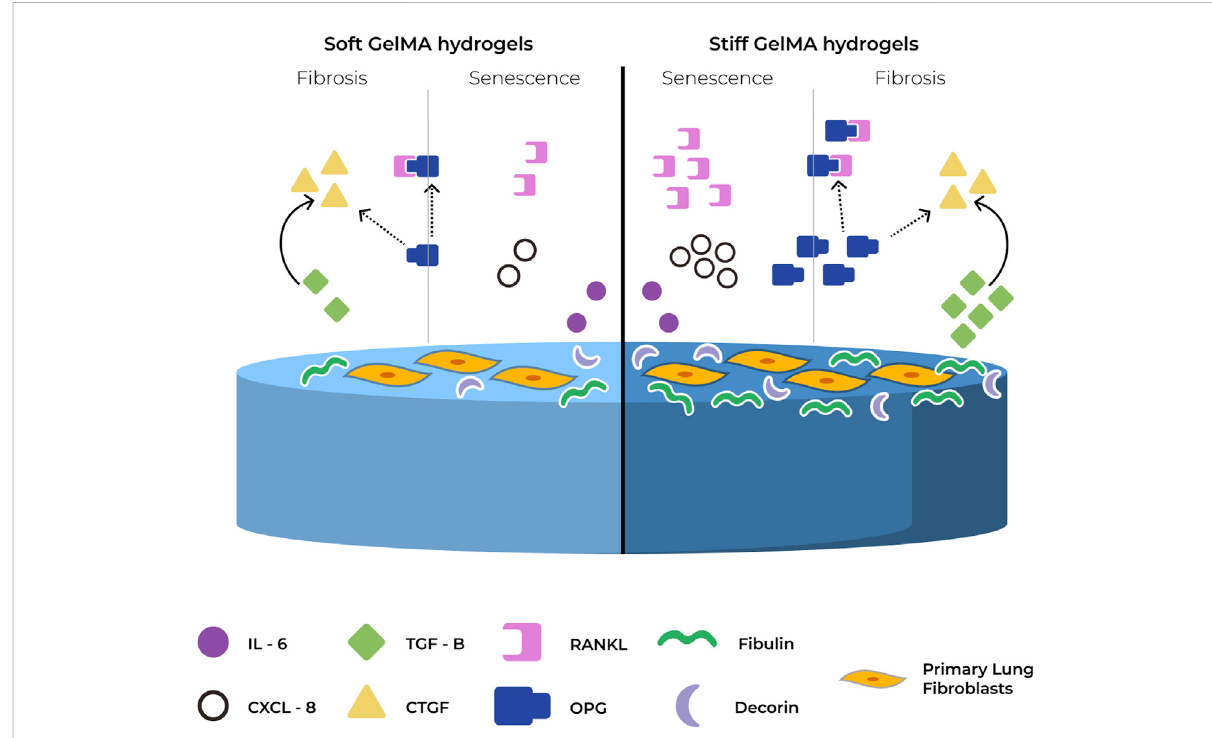
FIGURE 7 Summary of proposed mechanismfor OPG insenescenceand fi brosis. Inresponse to stiffness, Primary human lung fi broblasts show increased proliferation, higher deposition of ECM proteins and higher secretion of SASP and fi brosis related cytokines. OPG is proposed to act as a regulatory mechanism between senescence and fi brosis by binding to RANKL and CTGF, and potentially inhibiting their